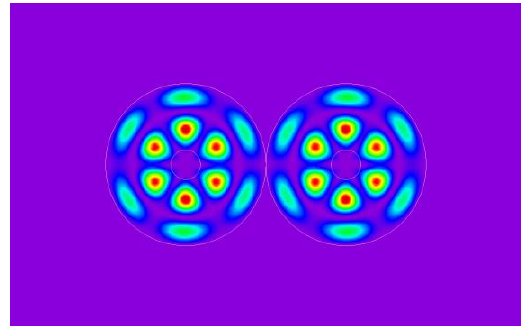
Figure 8. 2D power distribution plot for guided-mode ν = 79 ( 𝑛𝑒𝑓𝑓𝜈=79 = 1.420274).